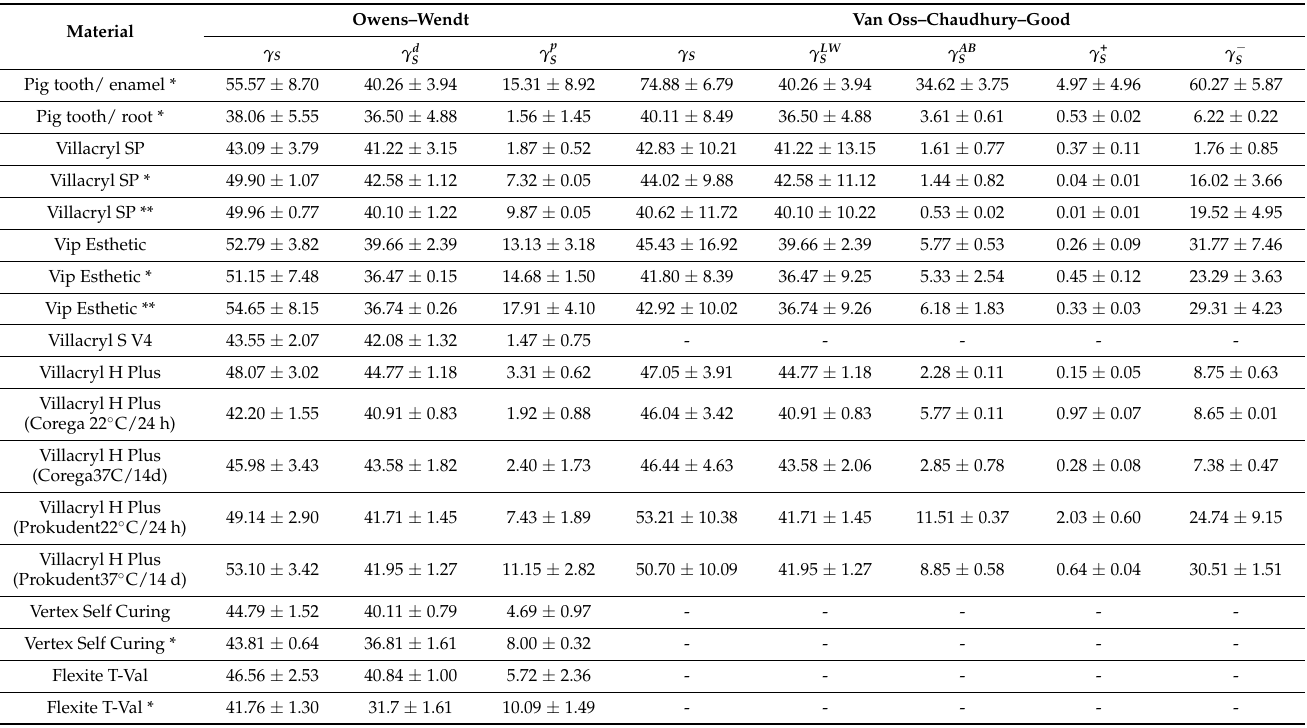
Table 4. Comparison of the SFE and its components (mJ/m 2 ).